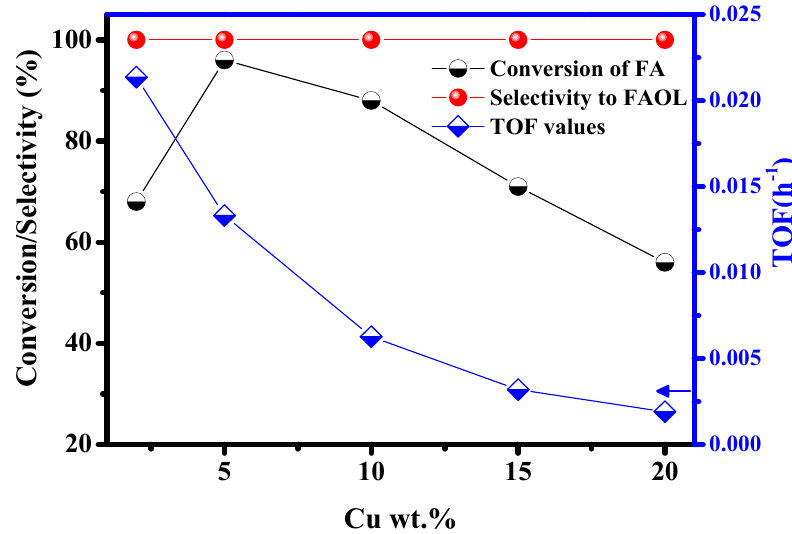
Figure 8. The effect of copper loadings (2–20 wt.%) on the CTH of FA to FAOL and corresponding TOF values are presented. Reaction Conditions: The catalyst amount (100 mg), 2-propanol (5 mL), FA (480 mg), reaction temperature—140 °C at 2 MPa N2 pressure and reaction time—4 h.